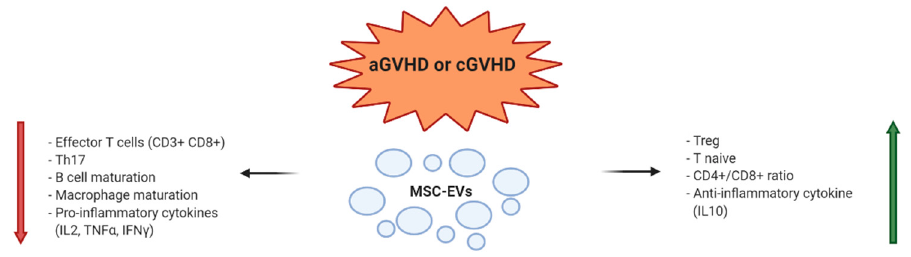
Figure 1. Mesenchymal stem/stromal cells-extracellular vesicle (MSC-EV) mechanisms of action in prevention and modulation of acute graft versus host disease (aGVHD) and chronic GVHD (cGVHD).